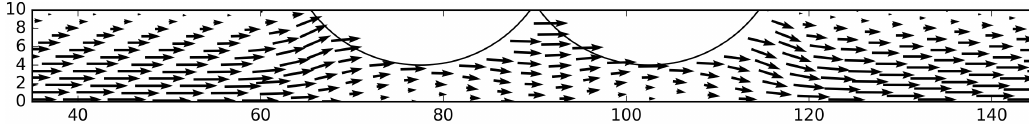
Figure 12. Velocity vectors for 2 rollers, c = 5 mm/s, L = 180 mm, RO = 0.6 and n = 1.